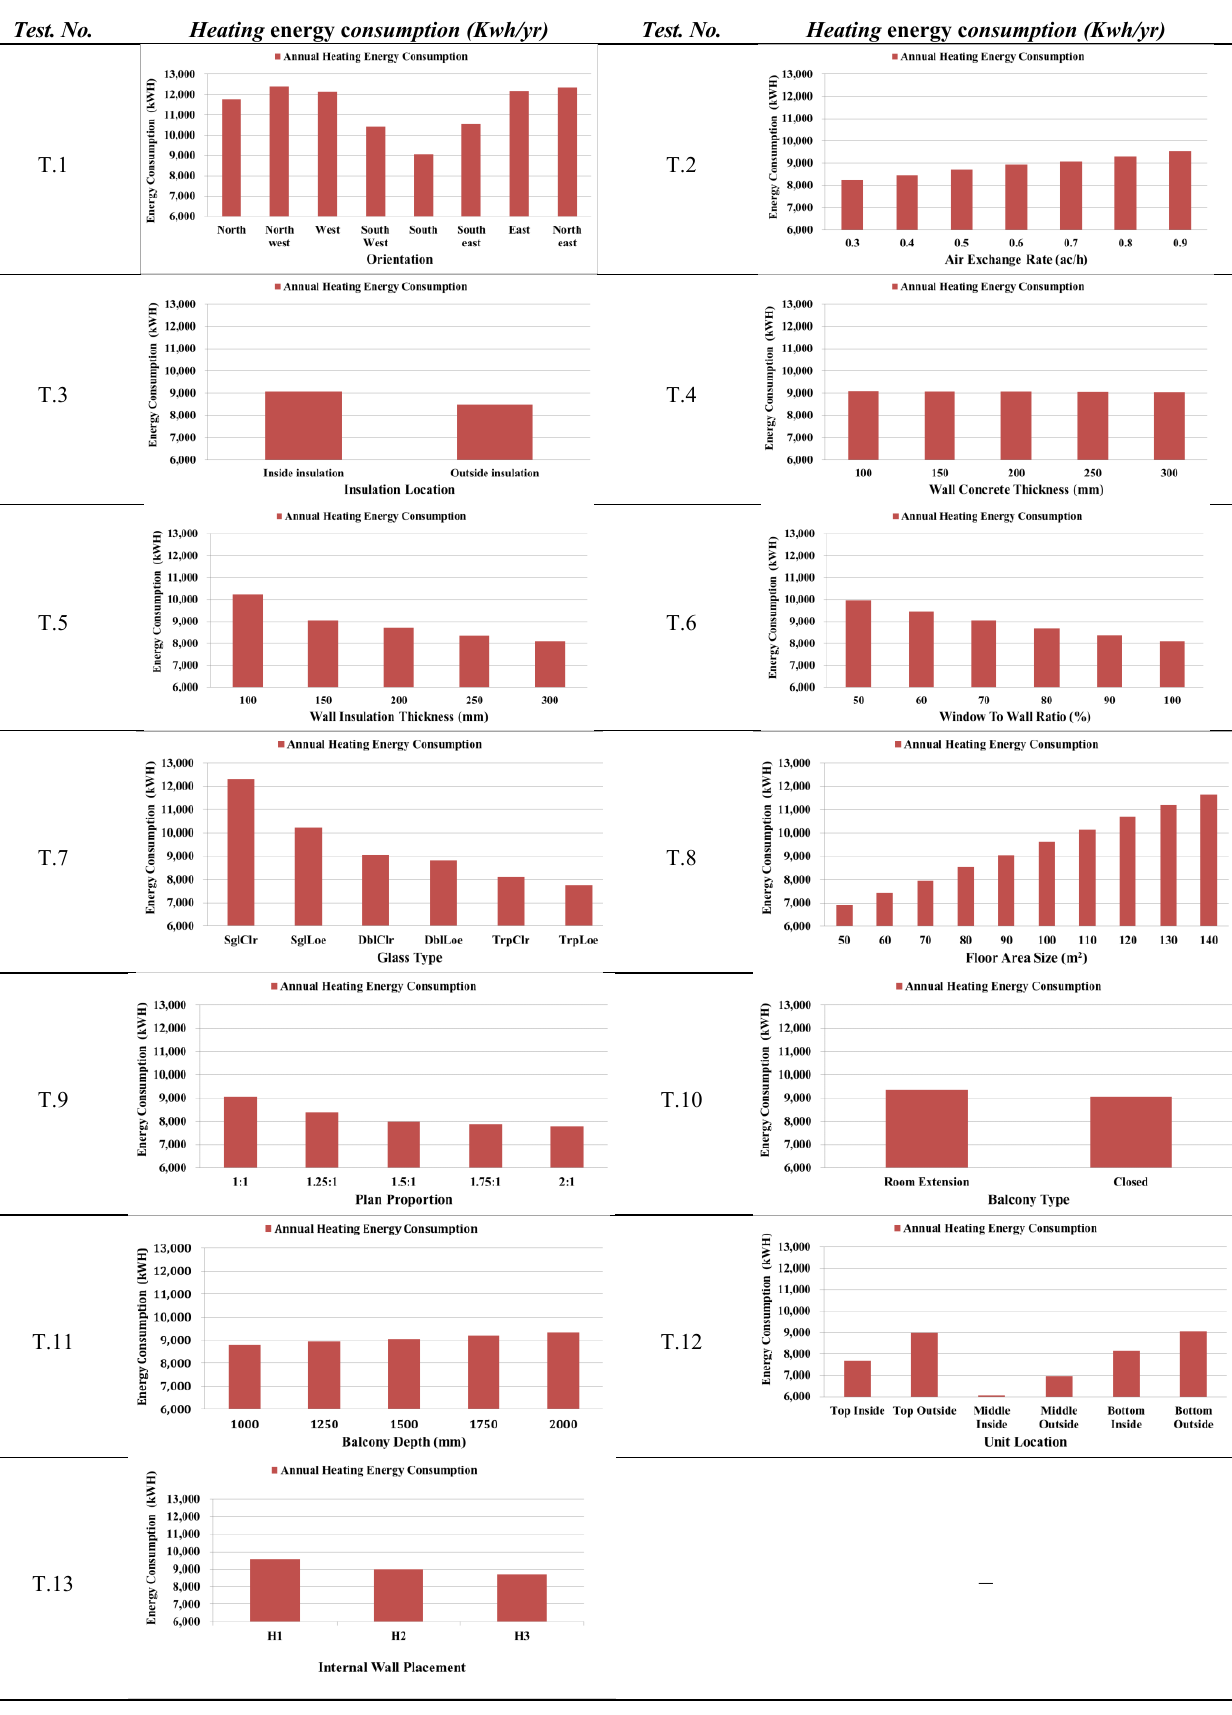
Table 6. Annual heating energy consumption with test